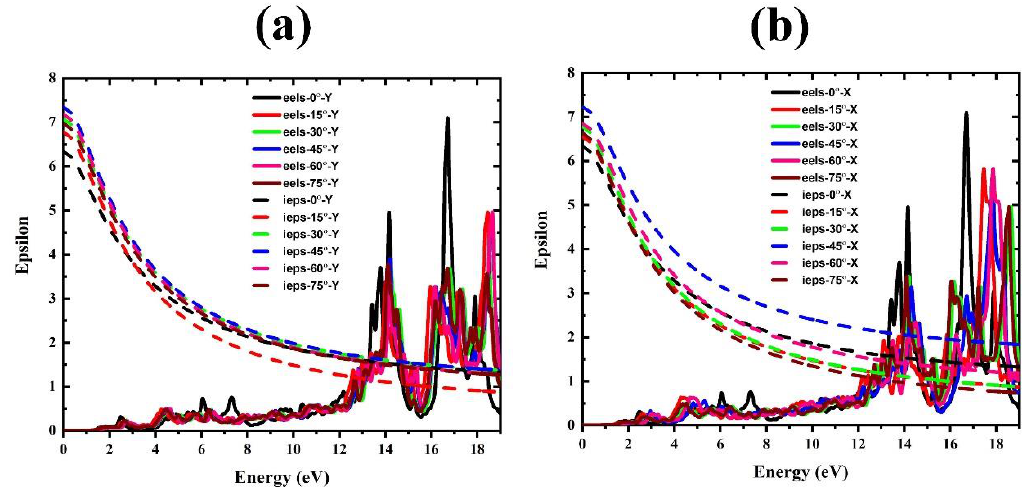
Figure 8. Imaginary part of dielectric function of FAPbBr 3 perovskite for different FA rotations: ( a ) in Y mode and ( b ) in X mode.